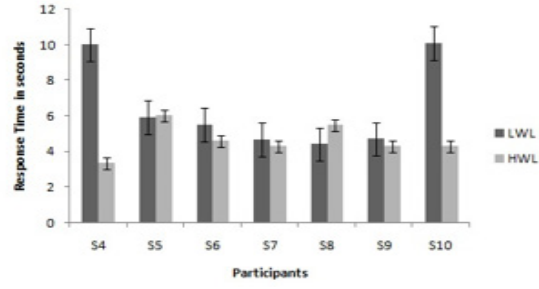
Figure 4. Response Time (in second) of system monitoring for participants who gave responses